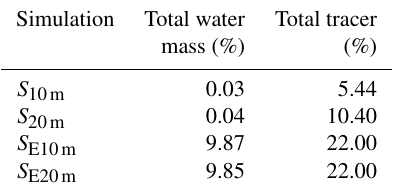
Table 5. The relative error in total water mass and tracer amount in the subsurface simulated in S 10m and S 20m benchmarked against S 2m and by S E10m and S E20m benchmarked against S E2m